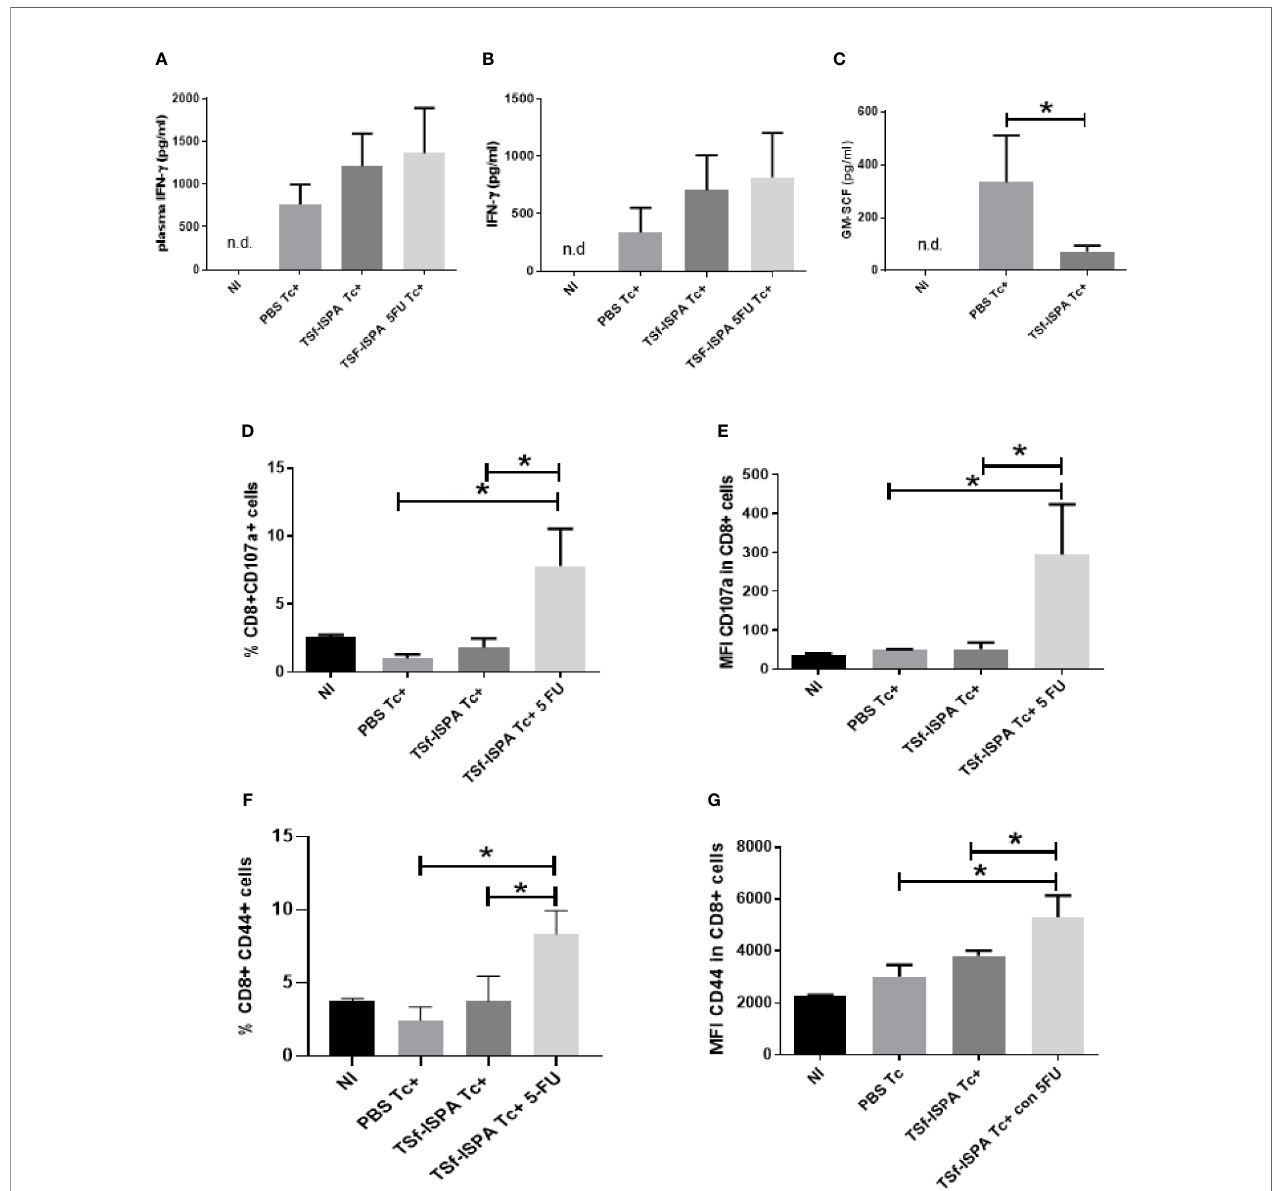
FIGURE 3 | MDSC depletion notably potentiates the CD8 effector response elicited by TSf-ISPA formulation. Mice immunized with TSf-ISPA or PBS were treated or not with 5FU and challenged with 900 trypomastigotes of the Tulahuen strain. (A) At 21 day p.i. plasma was obtained and the levels of IFN- g was measured by ELISA in control non-infected (NI), PBS-inoculated and infected mice (PBS Tc+), TSf-ISPA immunized and infected mice (TSf-ISPA Tc+) and TSf-ISPA immunized, infected and 5FU treated mice (TSf-ISPA Tc+ 5FU). (B) Mice were sacri fi ced at day 21 p.i. and splenocytes were cultured with conA and T. cruzi homogenate for analyzing the levels of IFN- g by ELISA in culture supernantant of each experimental group. (C) Plasma obtained at 21 p.i. was used to measure GM-CSF by ELISA in NI, PBS Tc+ and TSf-ISPA Tc+ mice. Finally, splenocytes cultured for 72 h were harvested and the expression of CD8, CD107a and CD44 were analyzed by FACS. (D) Percentage of CD8+ CD107a+ cells. (E) MFI of CD107a in CD8+ cells. (F) Percentage of CD8+ CD44+ cells, (G) MFI of CD44 in CD8+ cells. Data are expressed as means + standard deviations. Results are representative of two independent experiments (n = 3-5 mice per group, according to the survival of the experiment). *p < 0,05 between indicated groups of